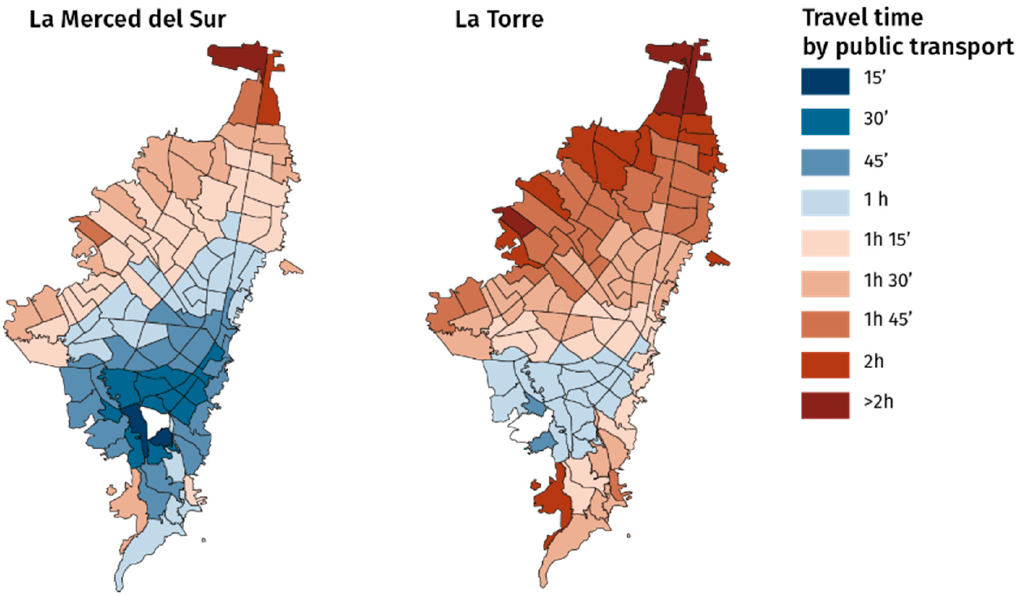
Figure 3. Travel time by public transport for the two examined neighbourhoods (source: [50]).